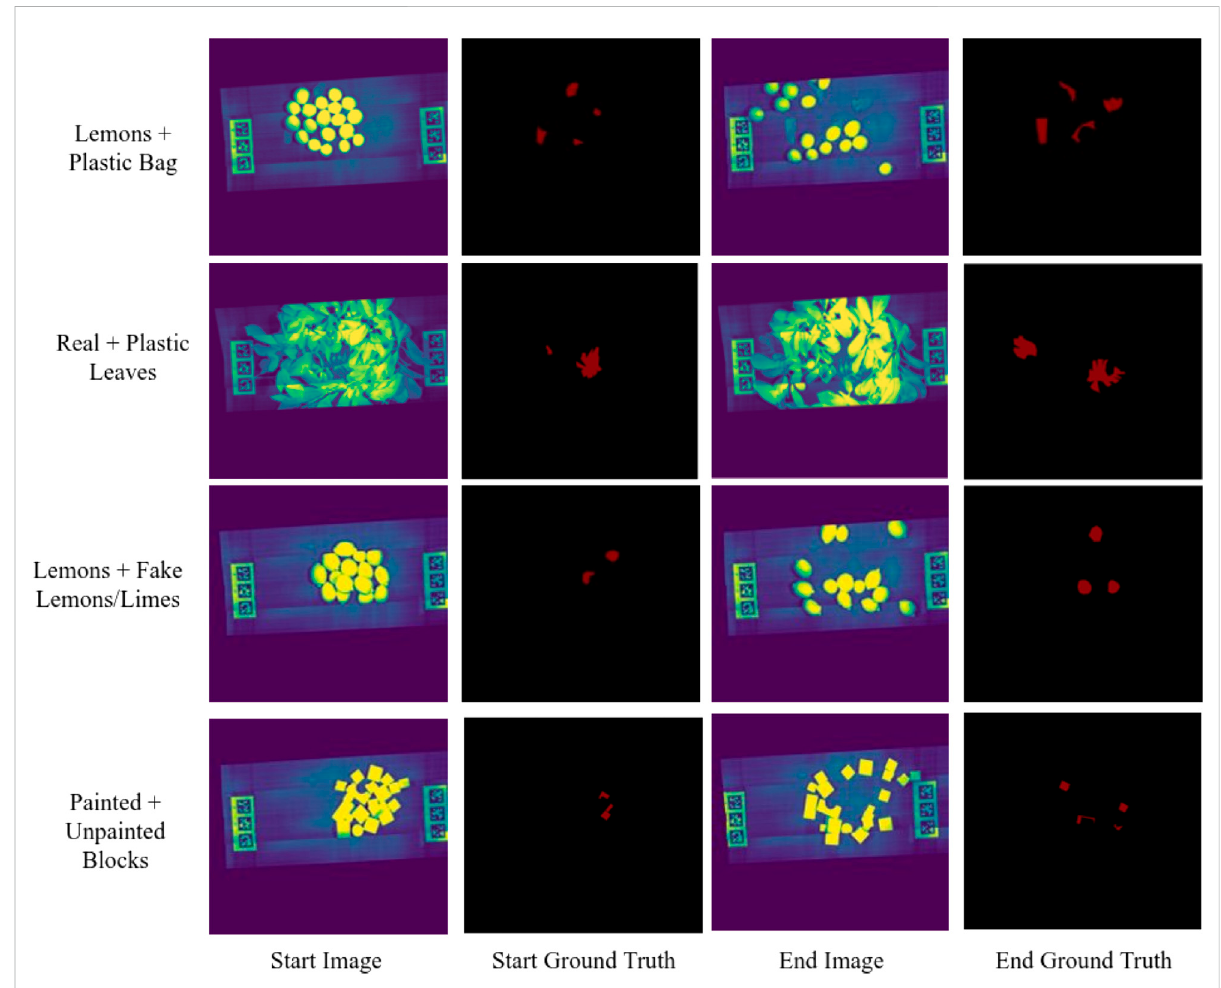
FIGURE 10 Four scenarios showing the pile of clutter after the initial scan, with associated ground truth labels for anomalous items. The end image shows the scene after disruption by three motion primitives, and ground truth shows the labeled anomalies in the